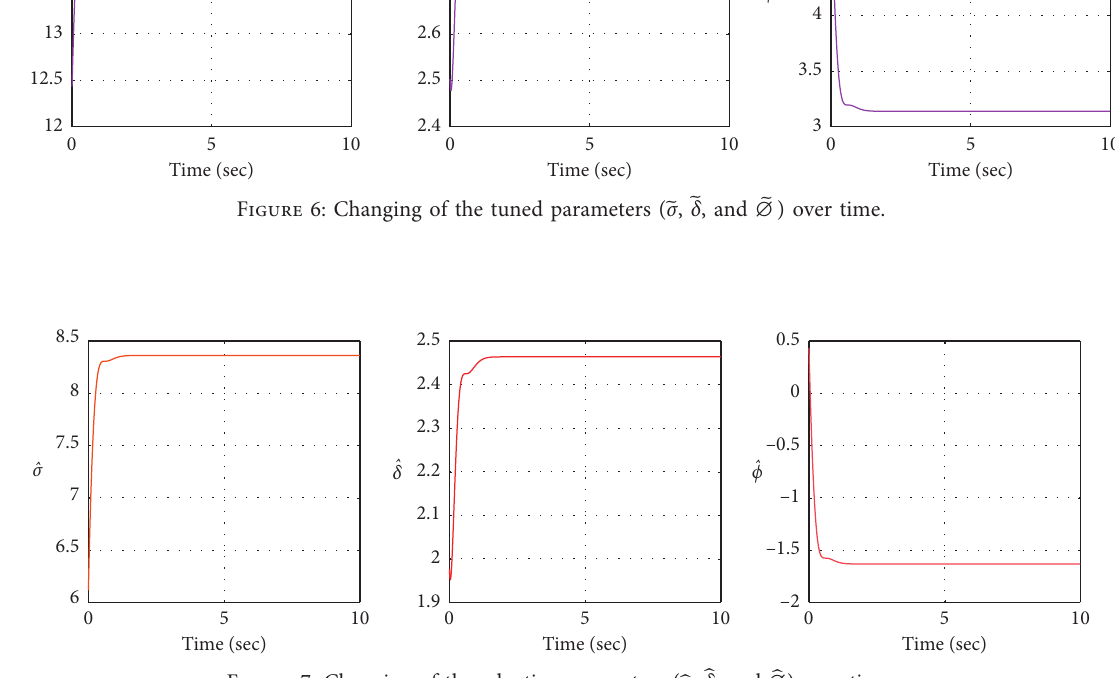
Figure 7: Changing of the adaptive parameters ( 􏽢 σ , 􏽢 δ , and 􏽢 ∅ ) over